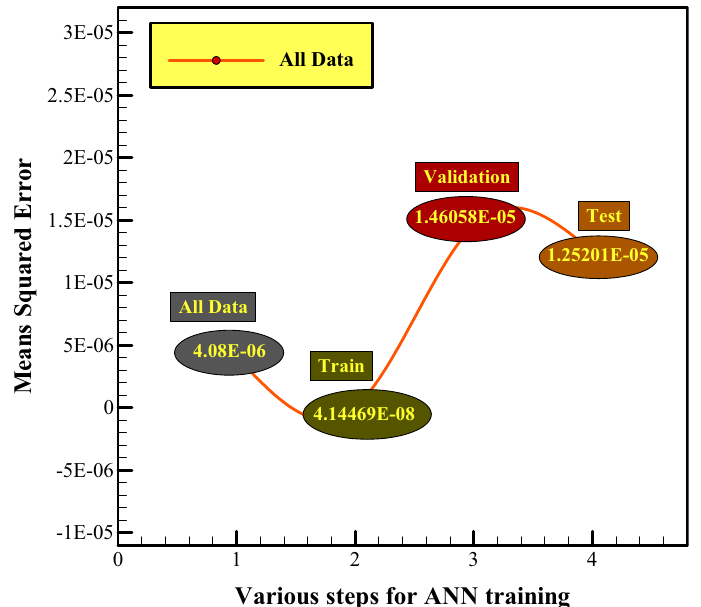
Figure 4. The MSE as a function of hidden layer